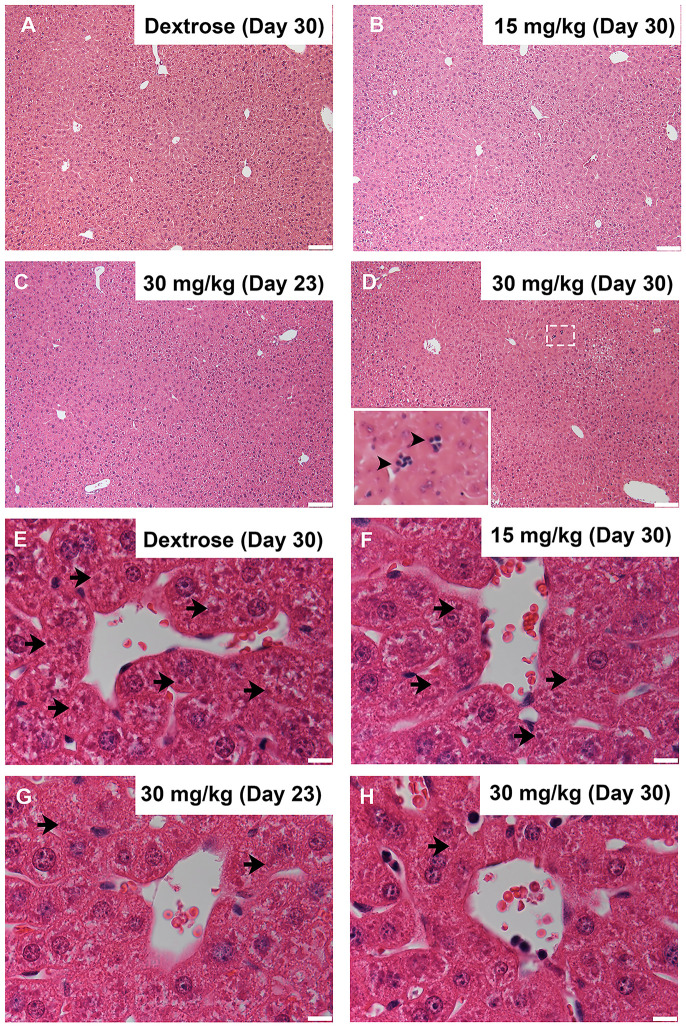
Histology of the liver in oxaliplatin-treated mice.Representative images of H&E histology of the liver of C57BL6J mice; (A, E) Dextrose, (B, F) 15 mg/kg, (C, G) 30 mg/kg ‘Day-23’ and (D, H) 30 mg/kg ‘Day-30’ groups; arrowheads = clustered cells, arrows–intracellular granules (A-D scale bar = 100μm; E-H scale bar = 10μm).